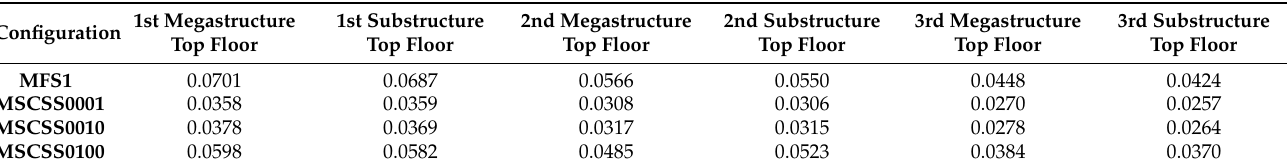
Table 4. The velocity response at a critical point of the investigated configurations under the El Centro wave (m s − 1 ).